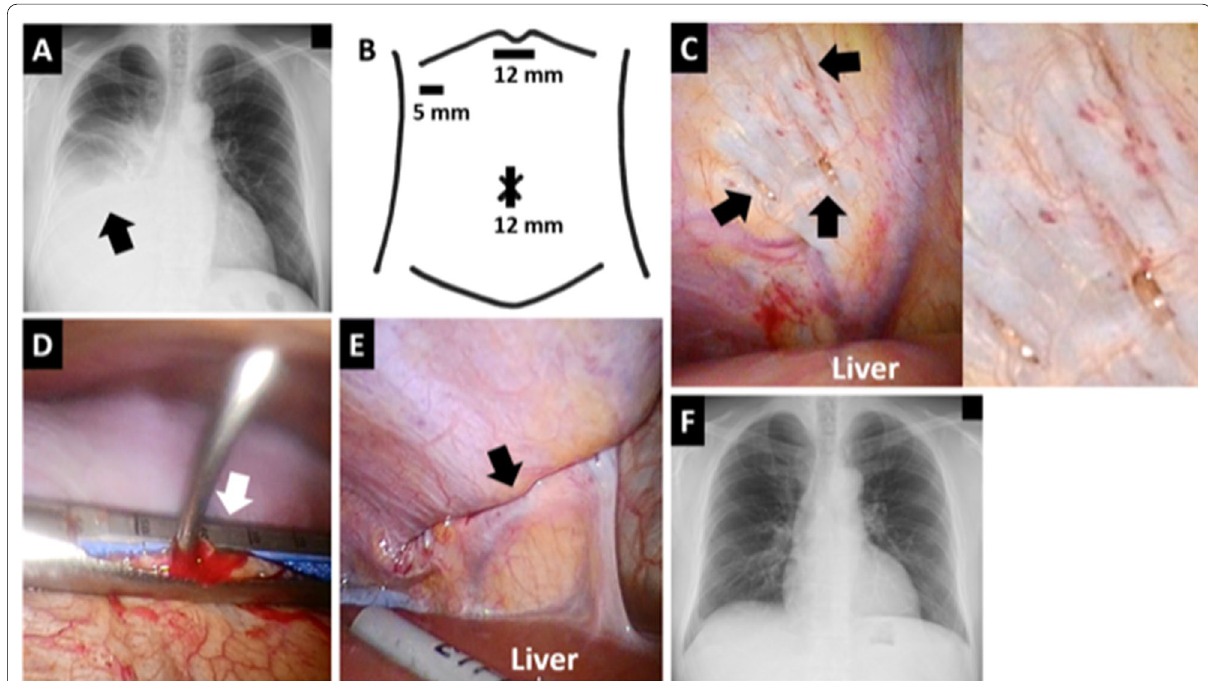
Fig. 2 Diagnosis and treatment for pleuroperitoneal communication in Patient 2. A Chest radiograph taken 6 months after the introduction of peritoneal dialysis. An arrow shows right pleural effusion. B Port positions in the laparoscopic approach. C Laparoscopic view of the diaphragmatic fistulas. Arrows show three fissures 1–2 mm in size in the central tendon of the right diaphragm over the liver. The image on the right is a magnified view of the fissures. D A thoracic view of the closure of the diaphragmatic fistulas using an automatic suture device. An arrow shows the grasped site of the right diaphragm, including all the fistulas. E Laparoscopic view of the closed site. The arrow shows the suture line. F Chest radiograph taken 10 months after